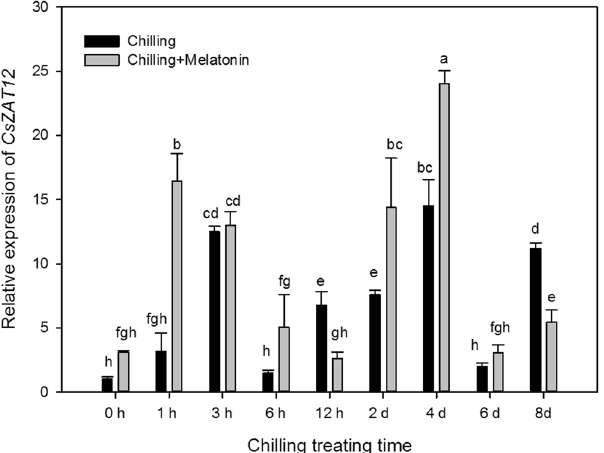
Figure 7. Effects of exogenous melatonin on transcript level of CsZat12 under chilling stress. Control, treating at 28/18 °C; Control + Melatonin, pre-treating with 200 μ M melatonin and treating at 28/18 °C; Chilling, treating at 15/8 °C; Chilling + Melatonin, pre-treating with 200 μ M melatonin and treating at 15/8 °C; Date represent means ± SD of third replicate samples. Different letters indicate a significant difference in a particular series at P < 0.05 according to ANOVA and Duncan’s multiple range tests.